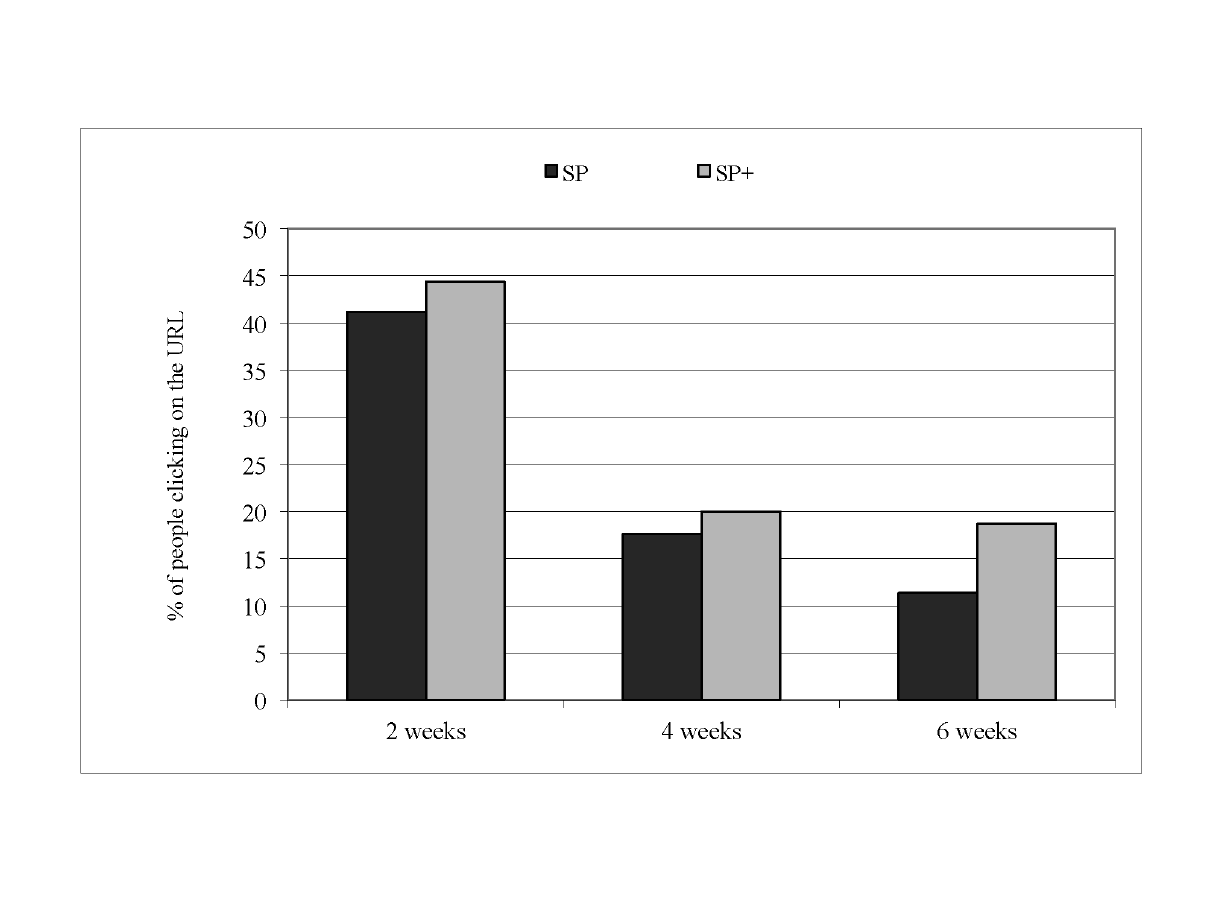
Figure 1. Percentage of participants given standard prompts (SP) and standard+ prompts (SP+) who clicked on the URL at different levels of prompt